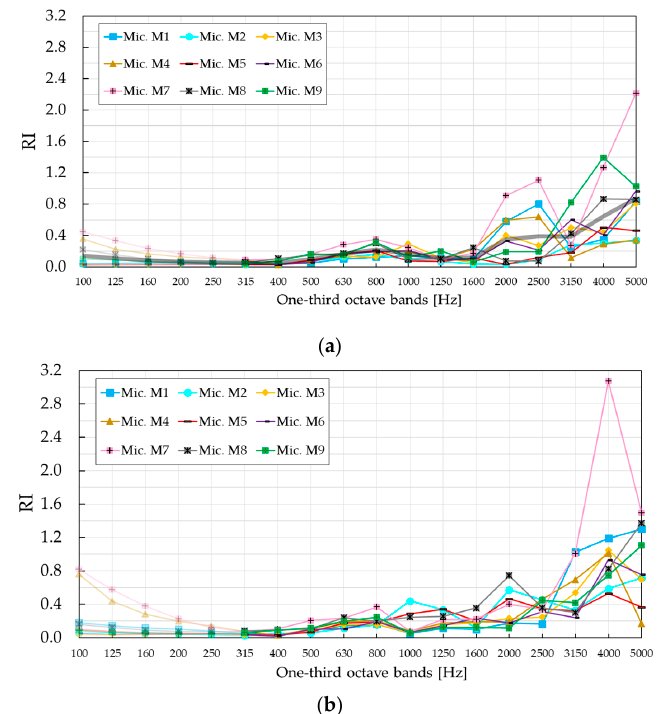
Figure 12. RI values measured at individual microphone positions M1–M9. Thick black curve shows the averaged RI values over all nine microphones. ( a ) Reflection index RI , configuration A; ( b ) reflection index RI , configuration B .